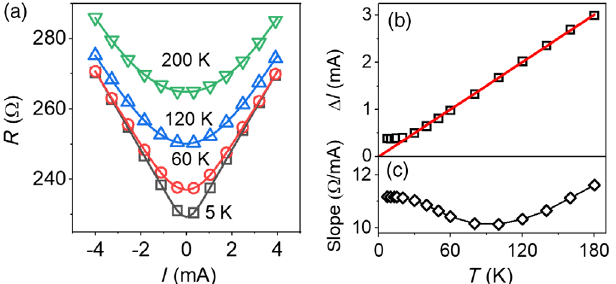
FIG. 2. (a) Symbols: R vs I for the same sample as in Fig. 1, at the labeled values of T . Curves: best fits with the linear function R ð I Þ ¼ R 0 þ α j I j convolved with the Gaussian g ð I Þ ¼ ffiffiffiffiffi p ð 1 = 2 π Δ I Þ e − I 2 = 2 Δ I 2 . Some of the data points are omitted for clarity, but fitting is performed for the entire data set. (b),(c) Parameters extracted from the data fitting: the Gaussian width Δ I (b) and the slope of the linear dependence (c). The line in (b) is the best linear fit of the data for T > 20